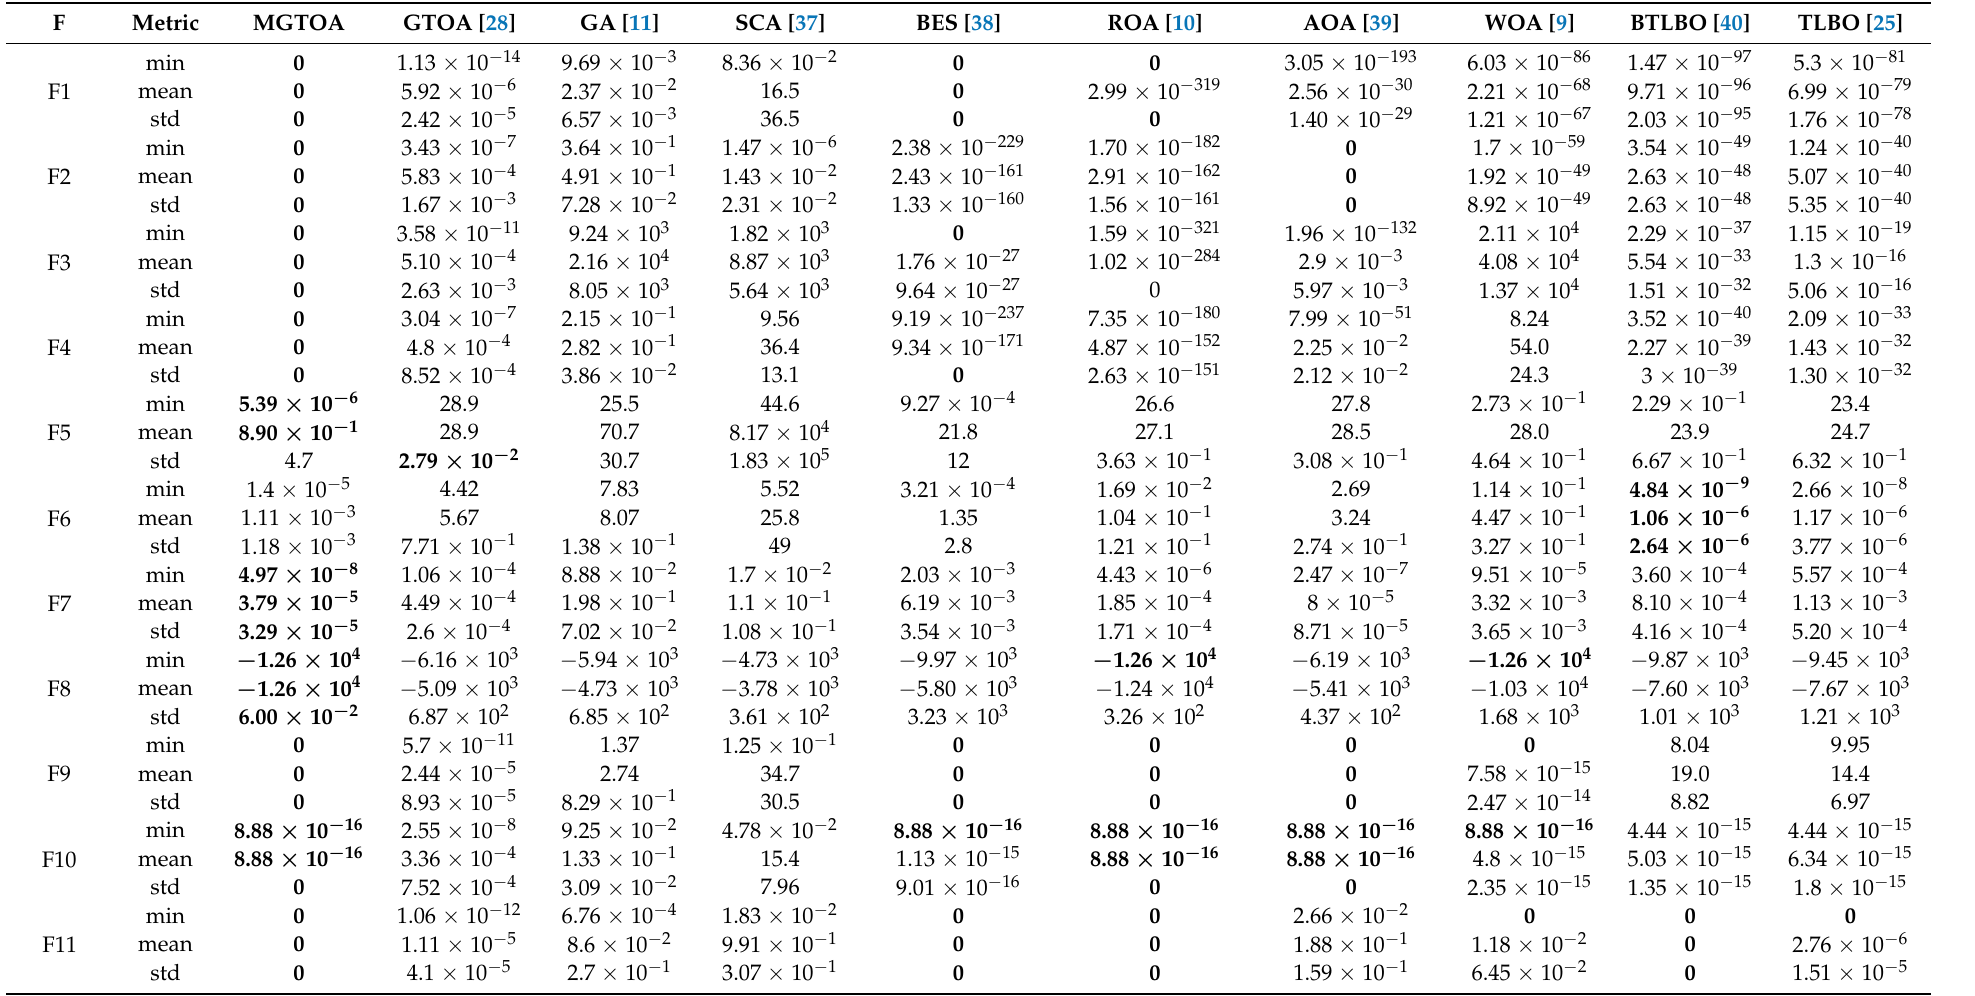
Table 3. Results of benchmark functions (F1–F13) under 30